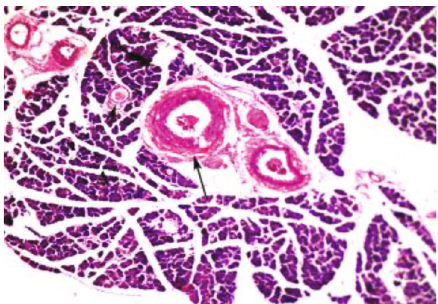
Figure 5: Photomicrograph of pancreatic tissue of P. granatum (200mg/kg BW)-treated animal showing atrophied pancreatic acini (A), pancreatic duct (arrowhead), and blood vessel with thick wall (arrow) (H&E) ( × 100).